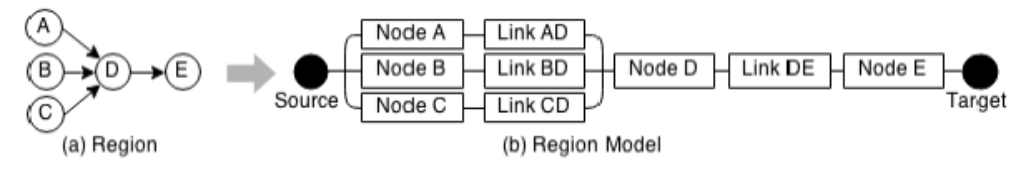
Figure 12. Reliability